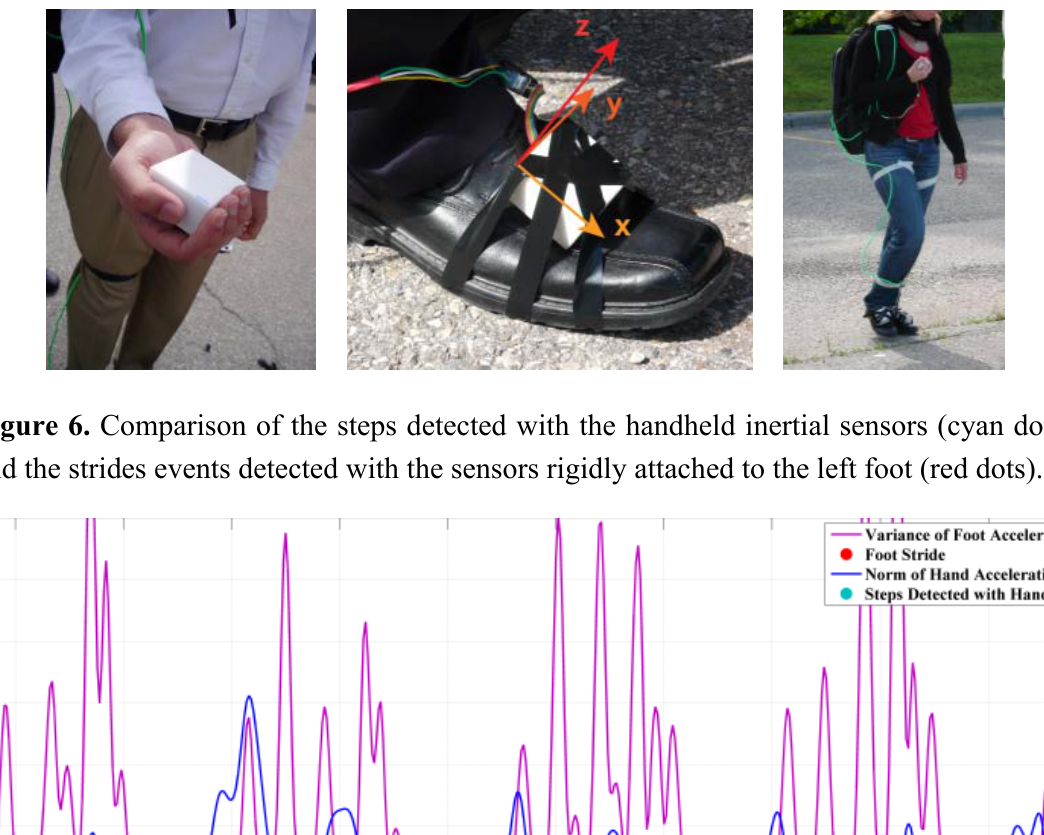
Figure 5. Pedestrian wearing the NavCube in a backpack with one IMU fixed on each foot and one IMU held in hand.